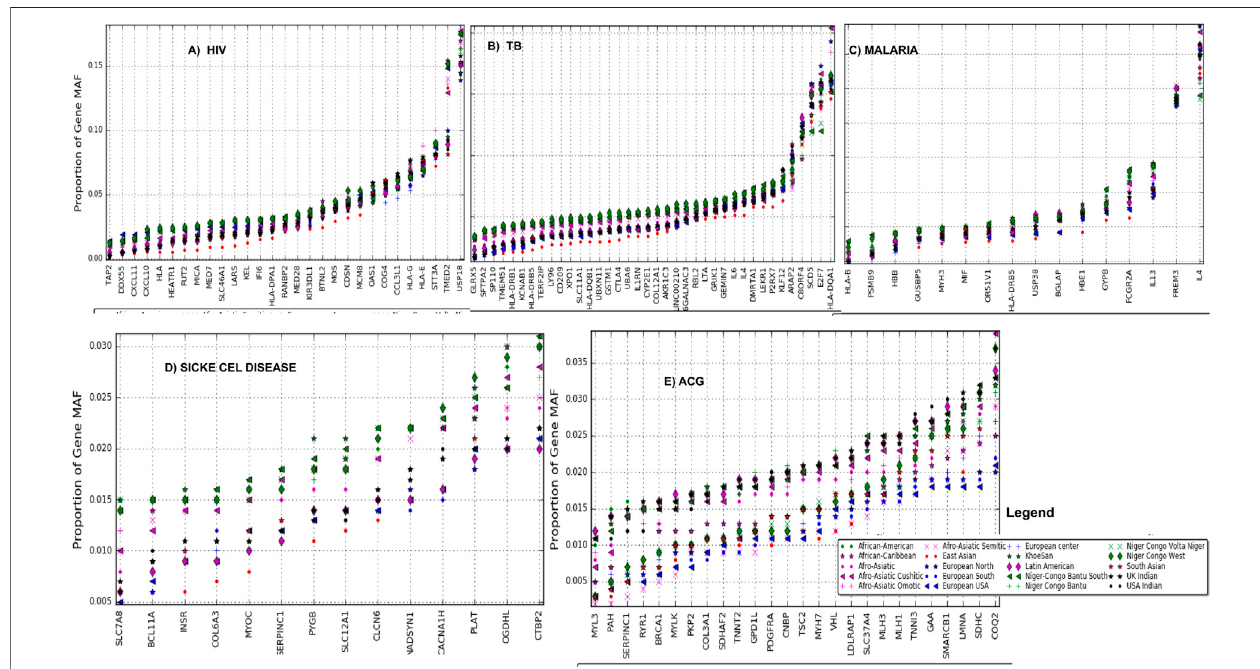
FIGURE 3 | Gene-speci fi city in SNP minor allele frequency: the distribution of the minor allele frequency at the gene level (A) HIV, (B) TB, (C) malaria, (D) sickle cell disease, and (E) ACG (actionable genes) among all ethnolinguistic cultural groups.